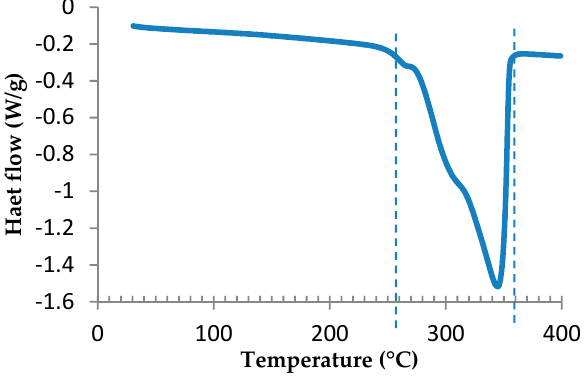
Figure 6. DSC analysis of magnesium hydroxide, 3 °C/min.